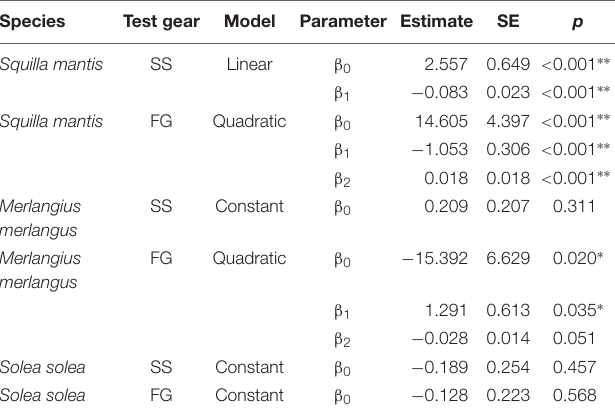
TABLE 2 | Generalized linear mixed model (GLMM) estimates of the Catch-Comparison.